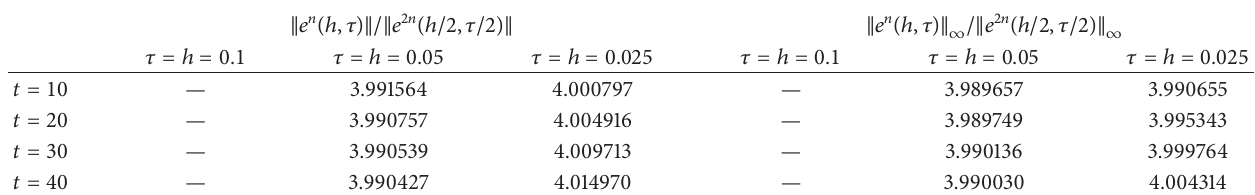
Table 2: The verification of the second convergence.